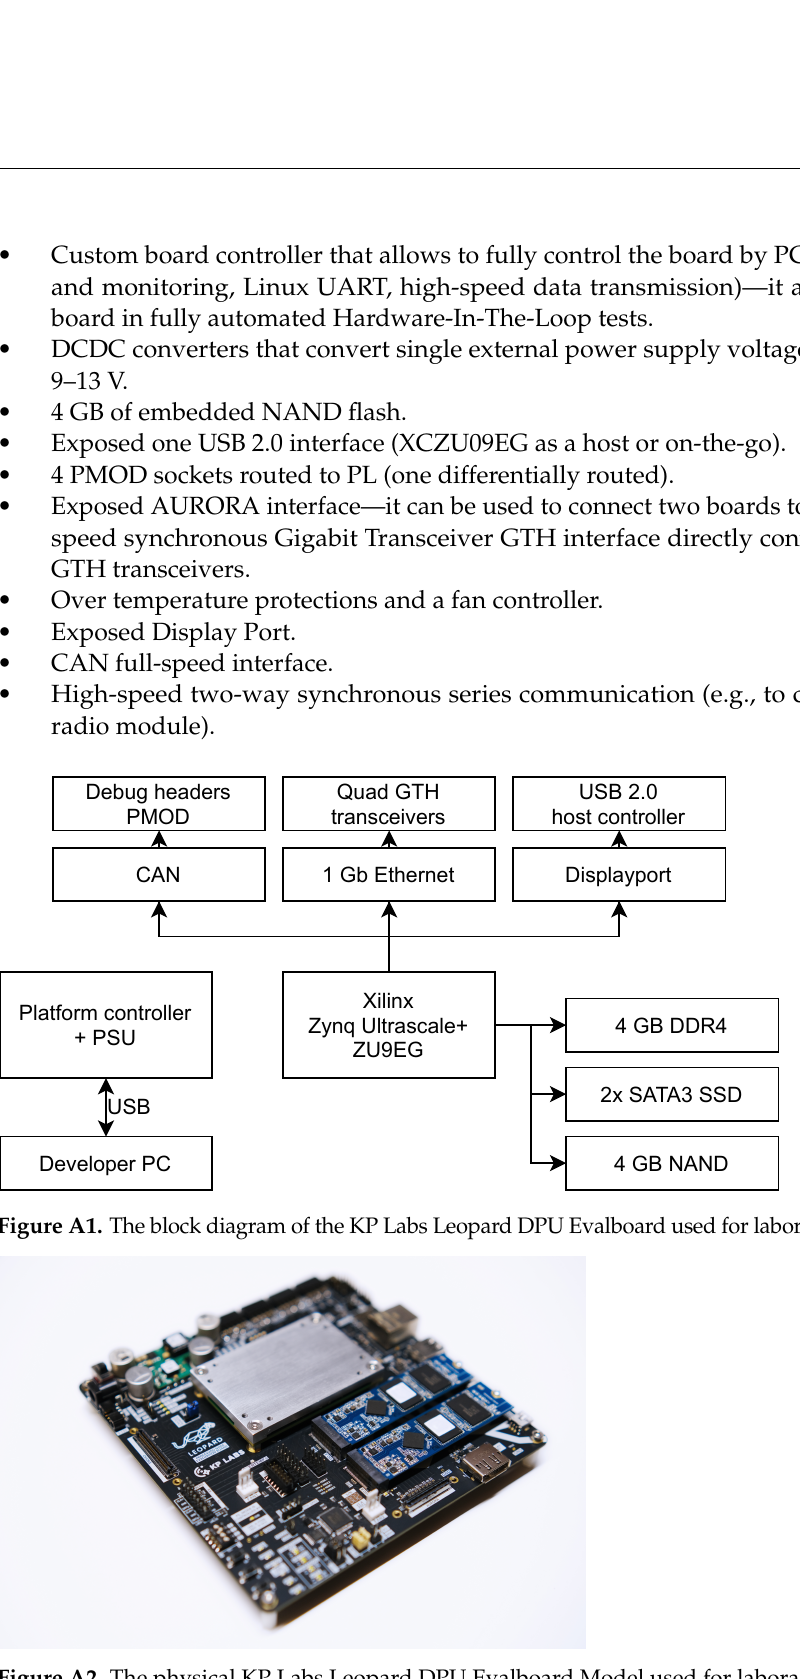
Figure A2. The physical KP Labs Leopard DPU Evalboard Model used for laboratory